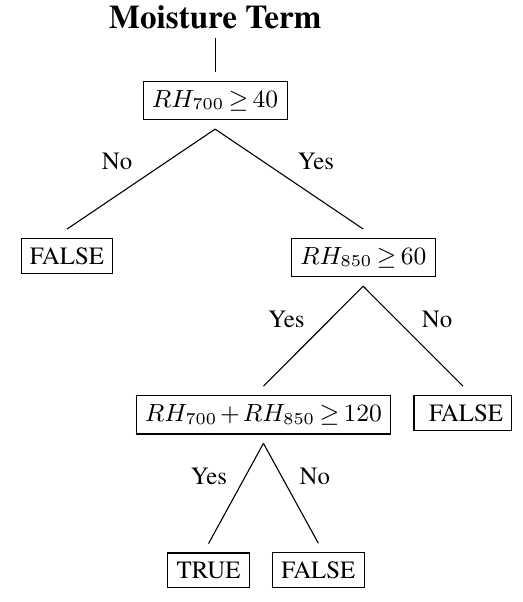
Fig. 6. Schematic diagram of the Locality Term 4.4